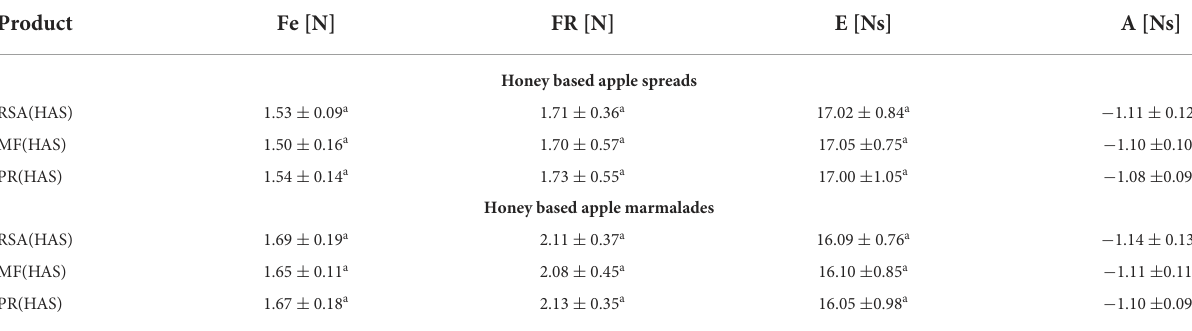
TABLE 4 Texture parameters of honey based apple spreads and marmalades.